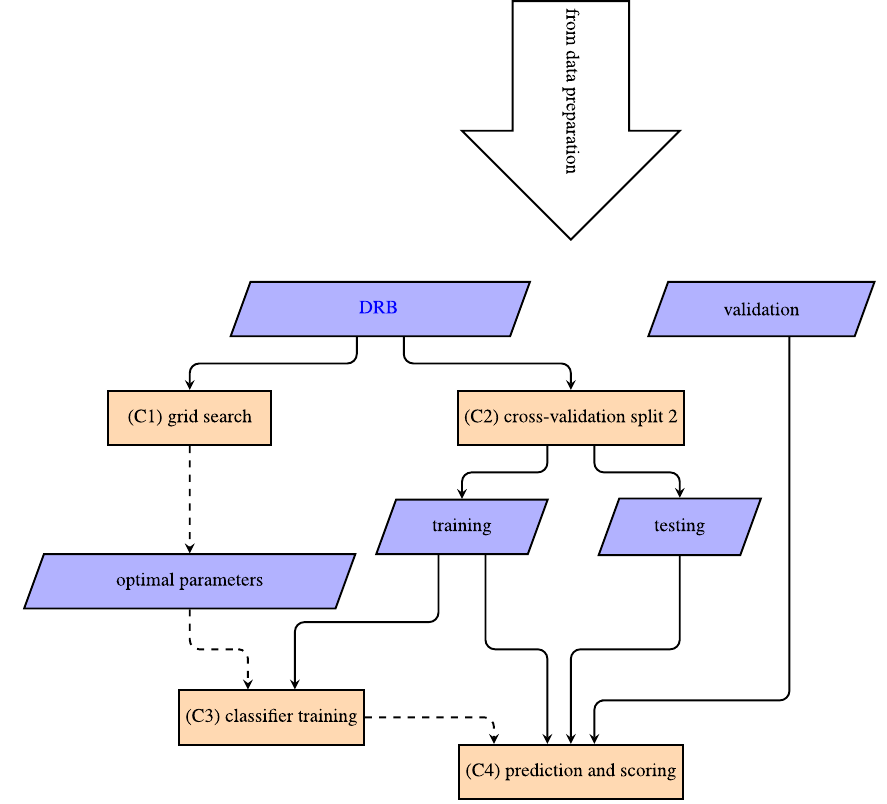
Figure 10. Flowchart of the classification pipeline. The solid arrows denote the data flow and the dashed arrows indicate influence of parameters. For clarity, the nodes for the data labels are omitted. DRB and validation were taken from each of the 25 validation splits made in the data preparation stage. For each classifier the DRB was used to optimize the classification parameters via a cross-validated parameter grid search (C1). DRB was then split 144 times into 80–20% training and testing batches (C2). The classifier was fit to training using the parameters found in the grid search (C3). Its performance was then evaluated over training , testing and validation (C4). Generated with pgf